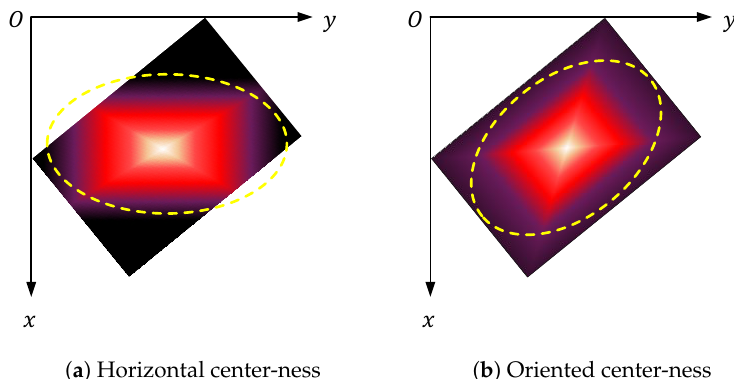
Figure 4. Heatmap of the horizontal and oriented center-ness. The distributions of horizontal and oriented center-ness scores are indicated by the ellipses with a yellow dotted